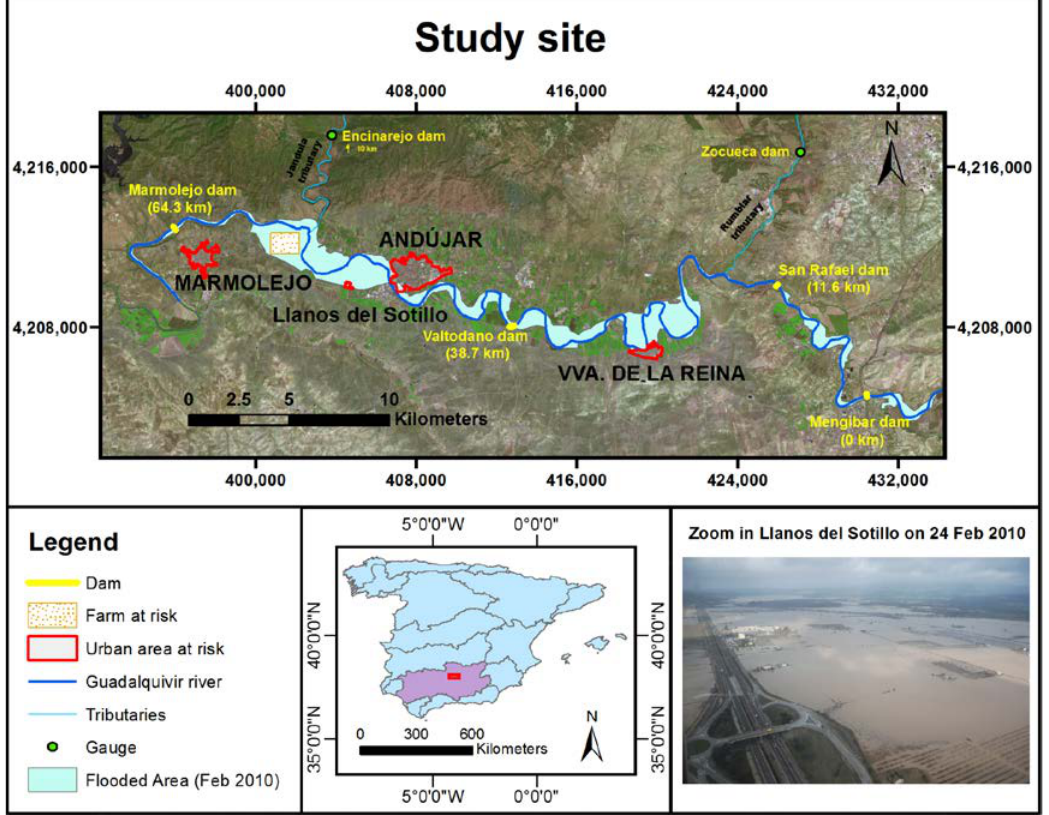
Figure 1. Study area along the Guadalquivir River including the inundated area (light blue) on 24 February 2010 for Q = 1950 m 3 · s − 1 at Marmolejo dam (flow from right to left). Urban areas at risk and hydropower stations are highlighted in red and yellow, respectively. Aerial photography shows a small portion of flooded areas in Llanos del Sotillo. Our earlier work [1] presents a detailed analysis of the flood dynamics in the confined valley of 6 km length downstream of Marmolejo dam.